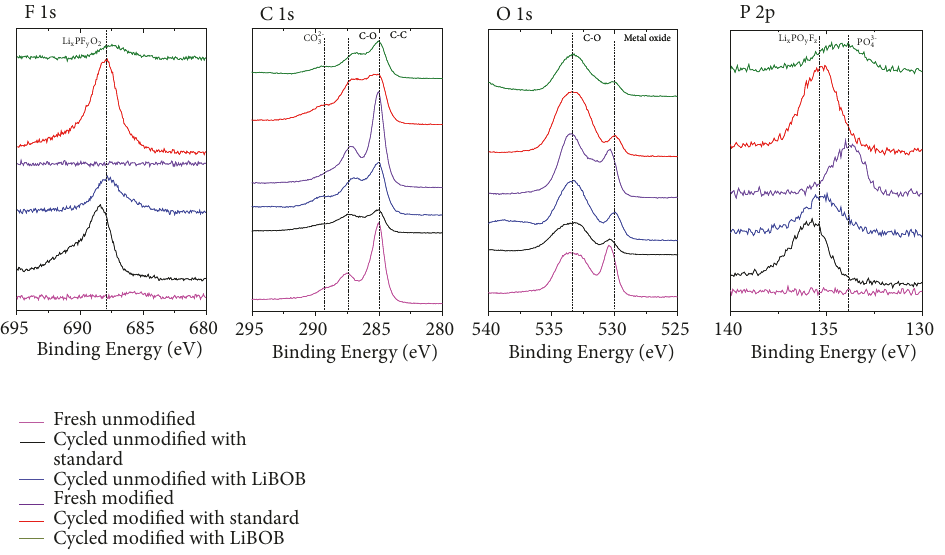
Figure 4: XPS surface analysis of fresh and cycled LNMO in PA modified and unmodified LNMO electrodes in graphite full cells with and without LiBOB in the electrolyte.